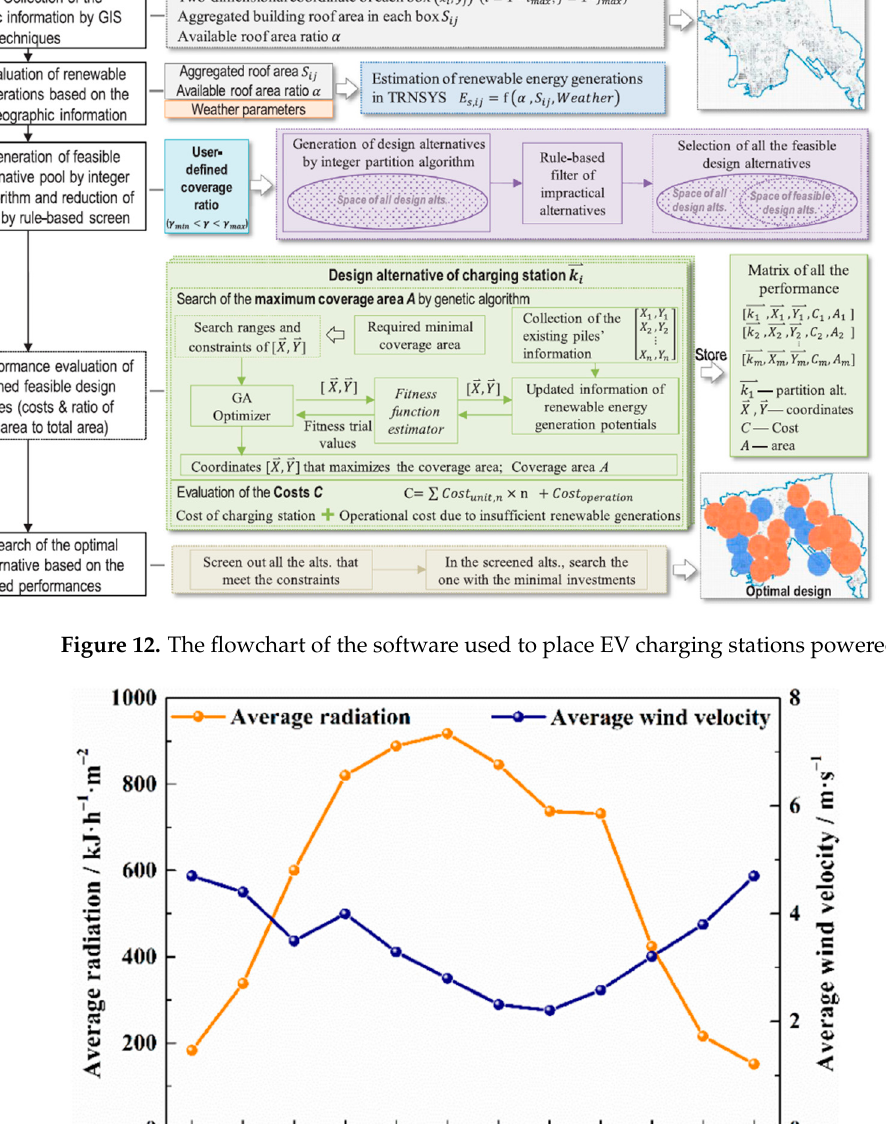
Figure 13. Monthly average radiation and wind velocity in Kaba-He